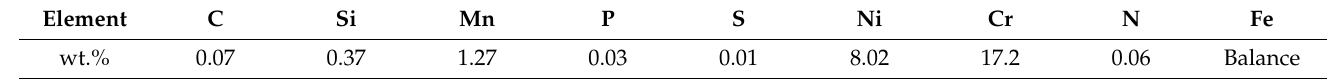
Table 1. Chemical composition of the 304 stainless